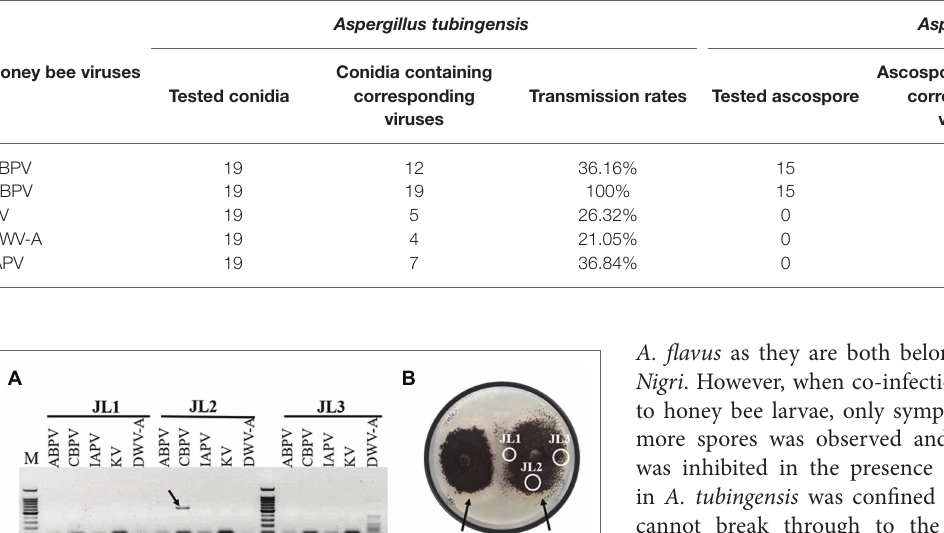
TABLE 1 | Detection of viruses in offspring spores of Aspergillus tubingensis and Aspergillus apis .